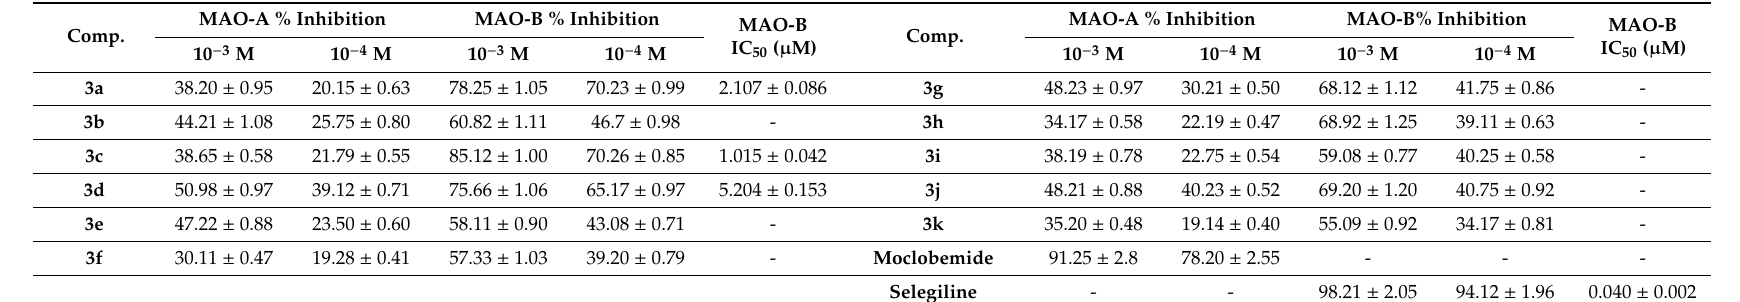
Table 2. Inhibition (%) of compounds 3a – 3k against MAO-A and MAO-B enzymes.